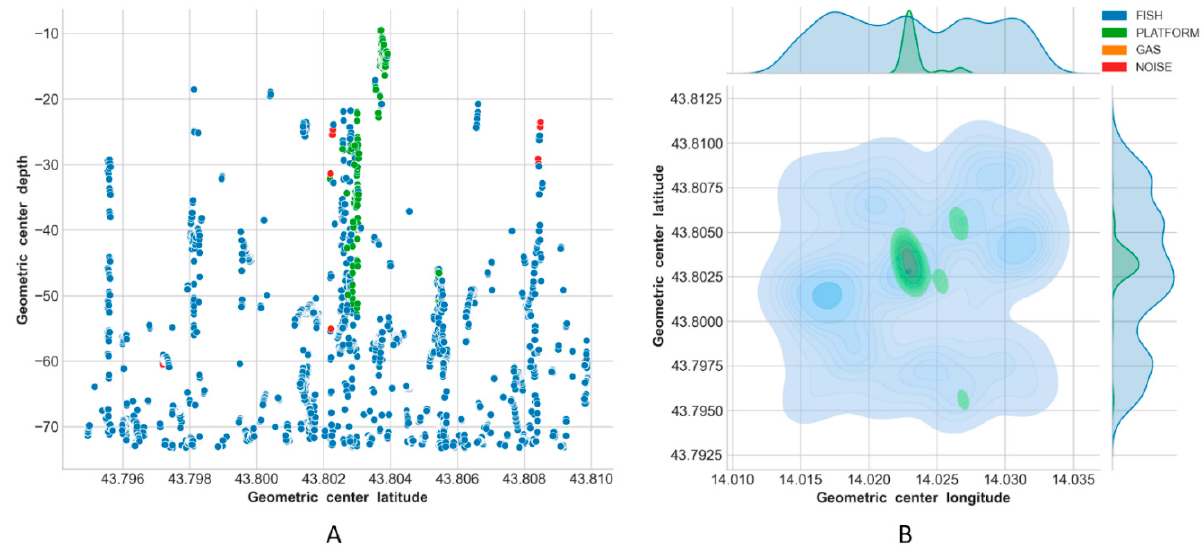
Figure 16. Predictions on Survey 4: latitude-depth representation ( A ), and Kernel Density Estimation plot ( B ).